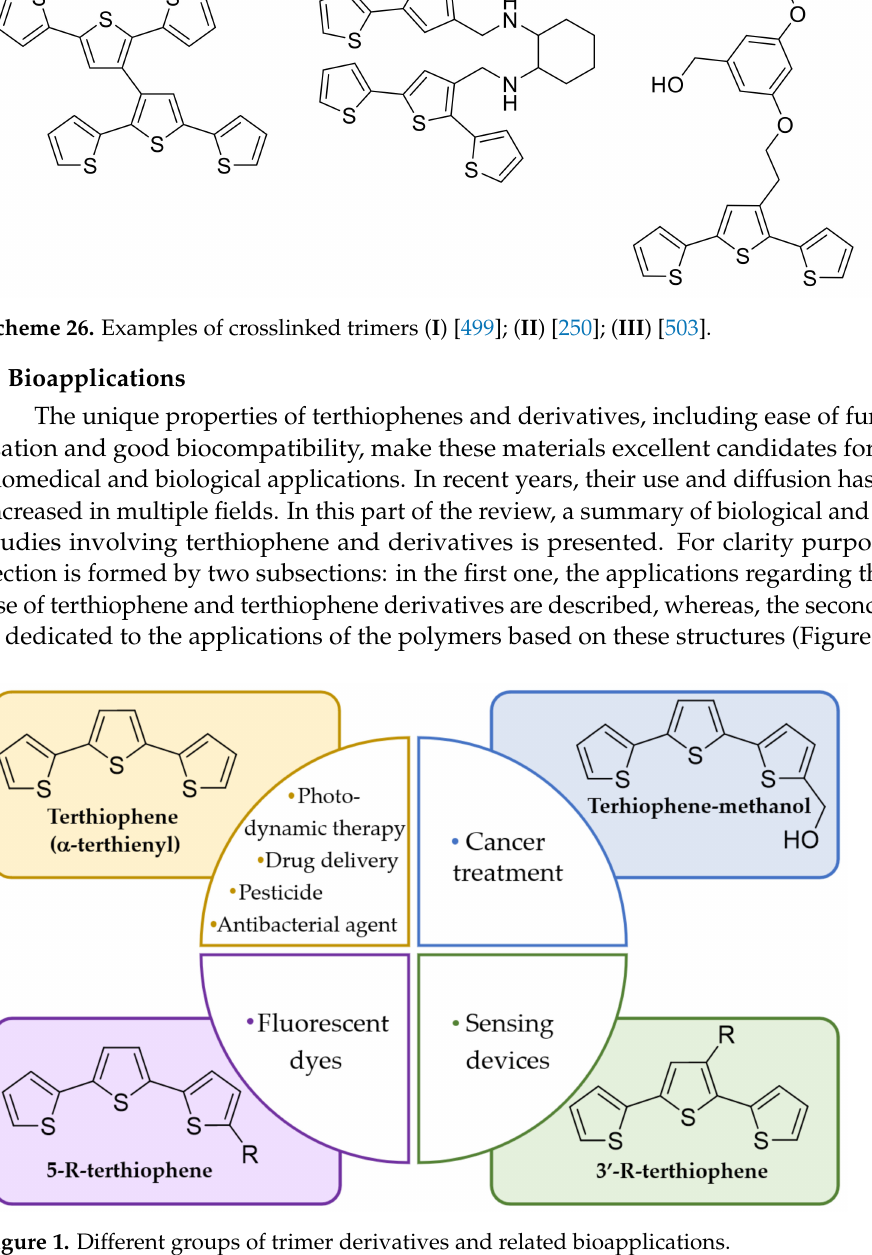
Figure 1. Different groups of trimer derivatives and related